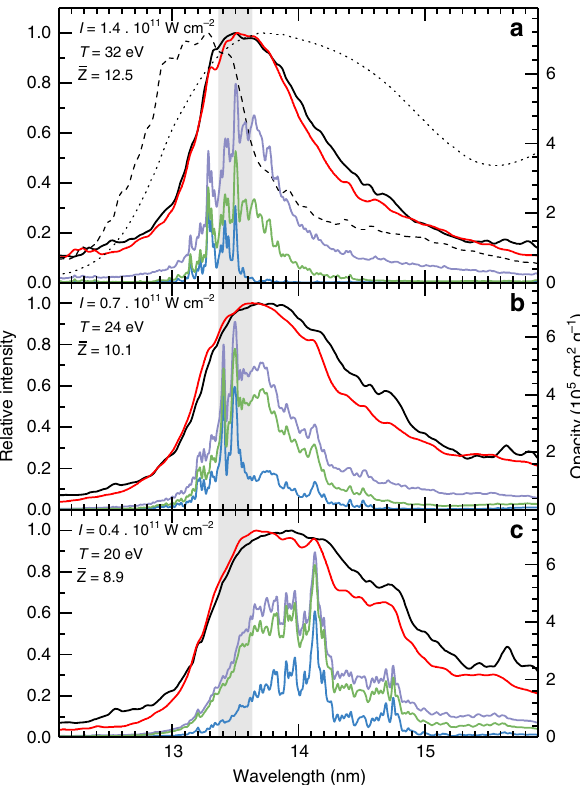
Fig. 4 Comparing calculation to experiment. Experimental spectra (black solid lines) and calculated fl uxes (red solid lines) are shown, normalized to their respective maximum. The spectral fl uxes are the result of the 1D radiation transport through a single-density (0.002 g cm − 3 ), single- temperature plasma (see main text). a Spectral fl ux calculated using an opacity spectrum from ref. 19 (dashed line) and the spectral fl ux obtained from HULLAC calculations 27 (dotted line). Opacity spectra, broken down according to the various contributions illustrated in Fig. 3 are also shown. The mean charge state (cid:1) Z of the calculation is given as well. The shaded gray area highlights the industrially-relevant 2 % bandwidth around 13.5 nm. b , c Same as in a but for two lower laser intensities and associated plasma